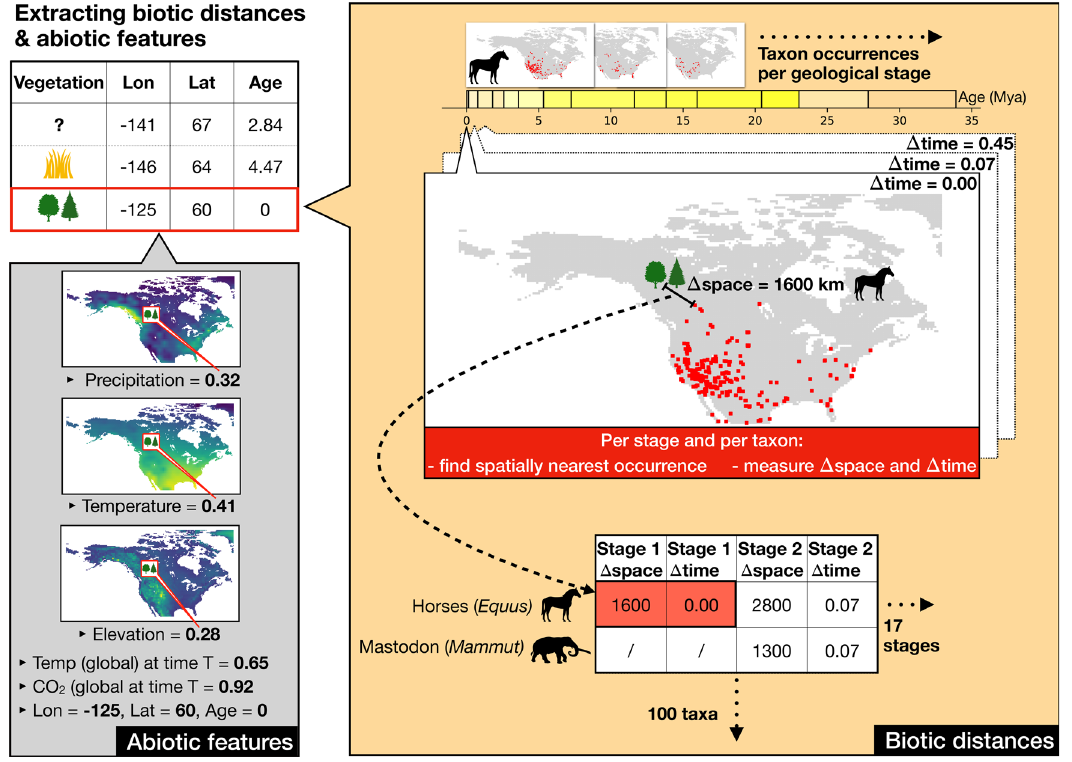
Fig.1|Theprocessoffeaturegeneration. Thework fl owisshownexemplarilyfor one point with current vegetation information (framed in red), located at the coordinates − 125, 60 (DecimalDegree System)and labeled as “ closed ” vegetation. Our database, compiled for this study, contains other points with current or past vegetation information, labeled as open (grass symbol) or closed (tree symbol). Once the model is trained it can be applied to estimate the vegetation inter- pretation for points in space and time, which are currently lacking such informa- tion (represented by the question mark). For the selected point, de fi ned by its